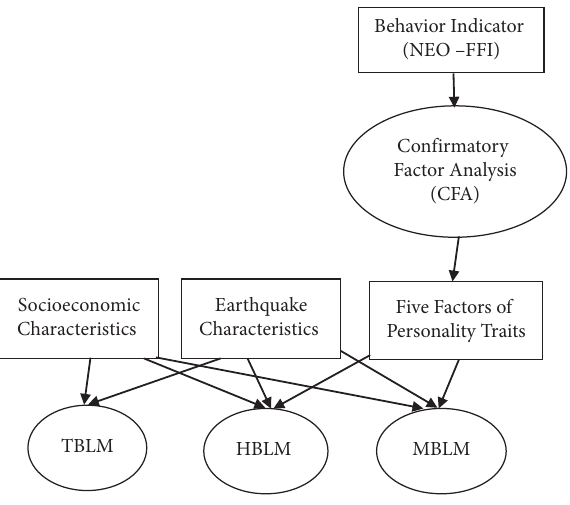
Figure 2: Proposed conceptual framework for evacuation choice